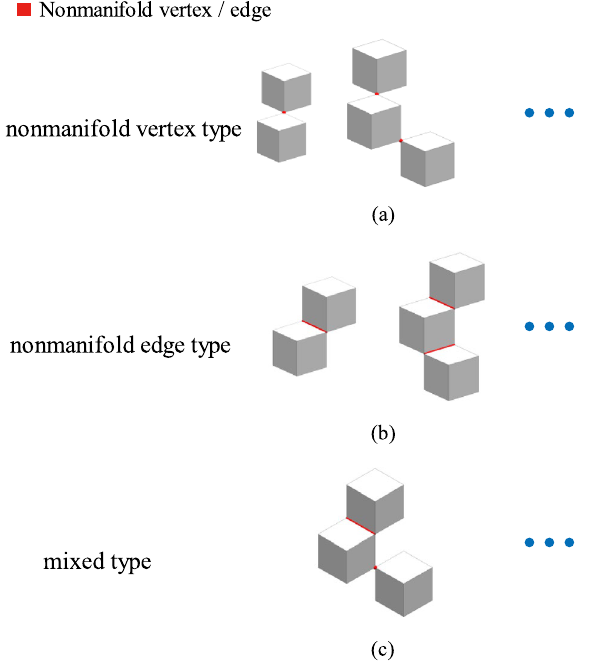
Figure 2. Structural representation of regular hexahedral